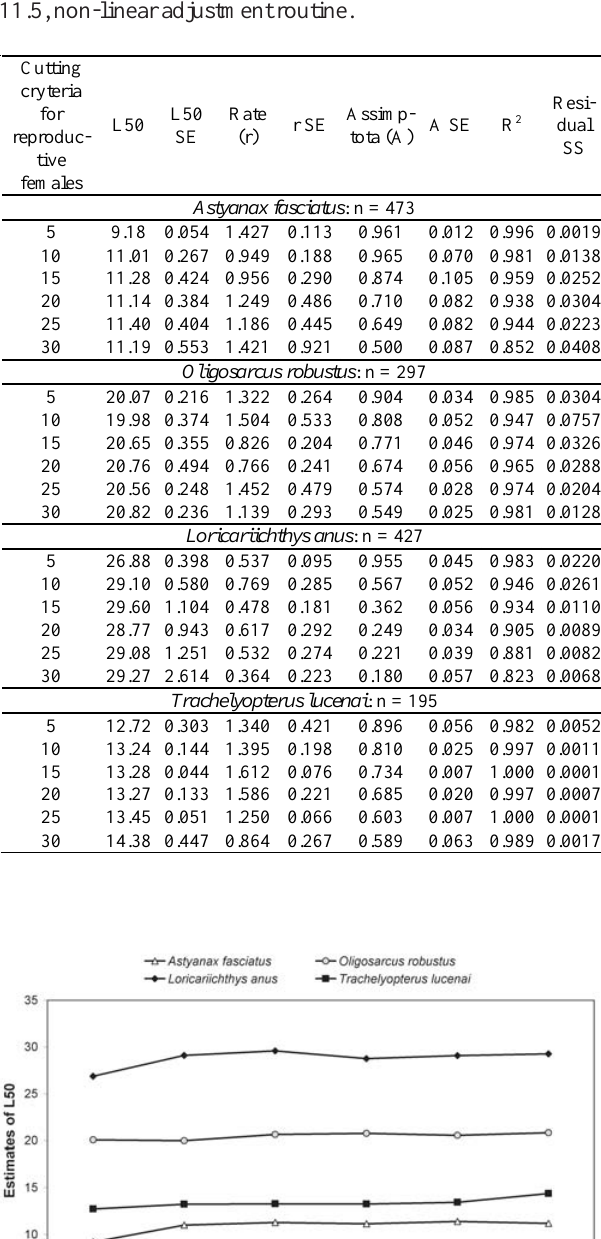
Table 2. Estimates of the size at first maturation (L ) for four 50 fish species using different values of the gonadossomatic index (GSI) as criteria of maturation. Estimates were performed using the equation: F = A / (1 + e –R (Lt – L50) ) through SPSS m 11.5, non-linear adjustment routine.